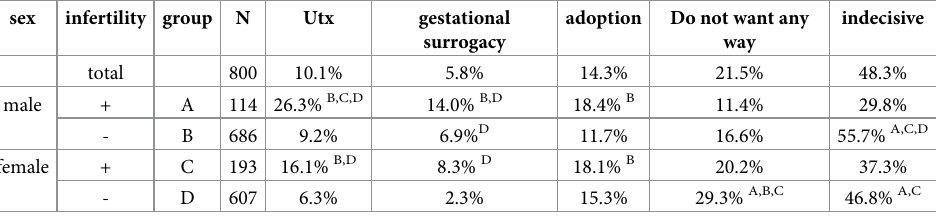
Table 10. Attitudes towards each UTx, gestational surrogacy, and adoption assuming that the respondents or their spouse are suffering from absolute uterine factor infertility.